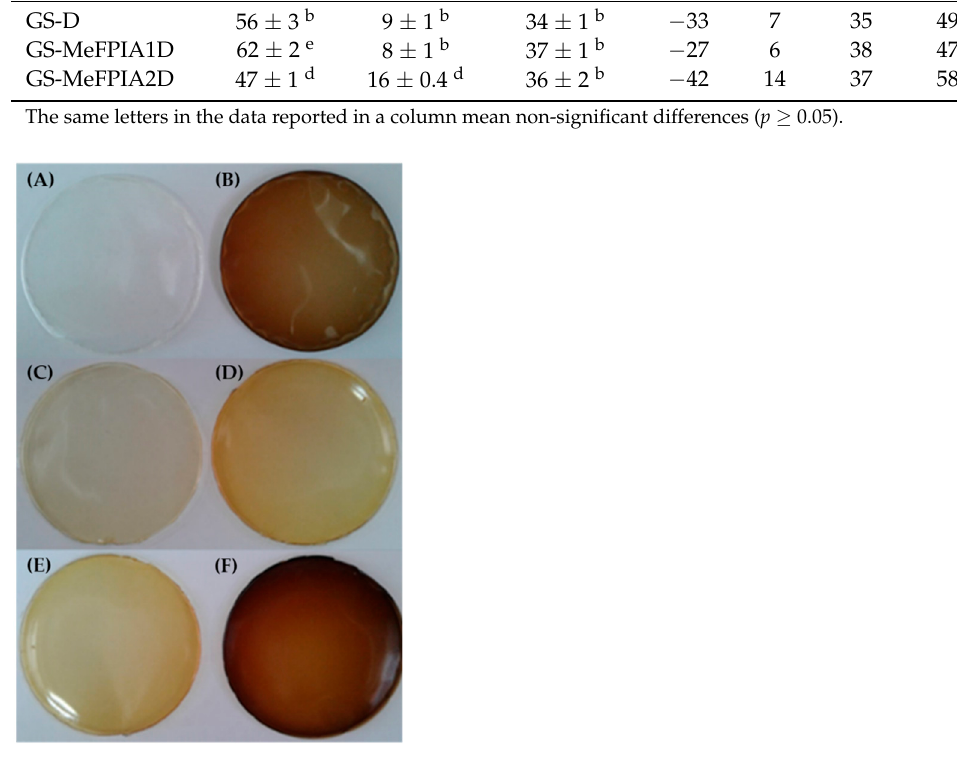
Figure 3. Photographs of the different films: ( A ) GS, ( B ) GS-D, ( C ) GS-MeFPIA1, ( D ) GS-MeFPIA1D, ( E ) GS-MeFPIA2, and ( F ) GS-MeFPIA2D.